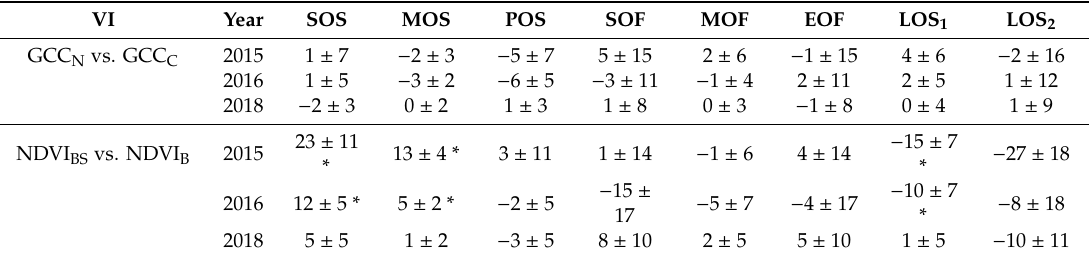
Table 7. The di ff erence (number of days, mean ± 95% confidence interval) of phenophases between the same vegetation index measured with di ff erent sensors. VI Year SOS MOS POS SOF MOF EOF LOS 1 LOS 2 GCC N vs. GCC C